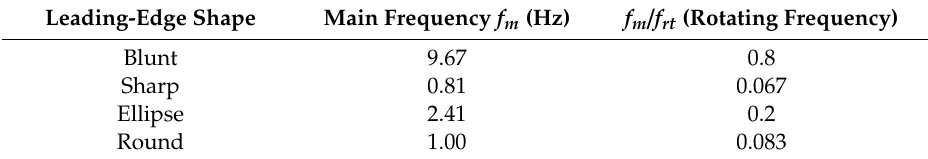
Table 2. Main / dominant frequency value in the impellers with di ff erent leading-edge shape.